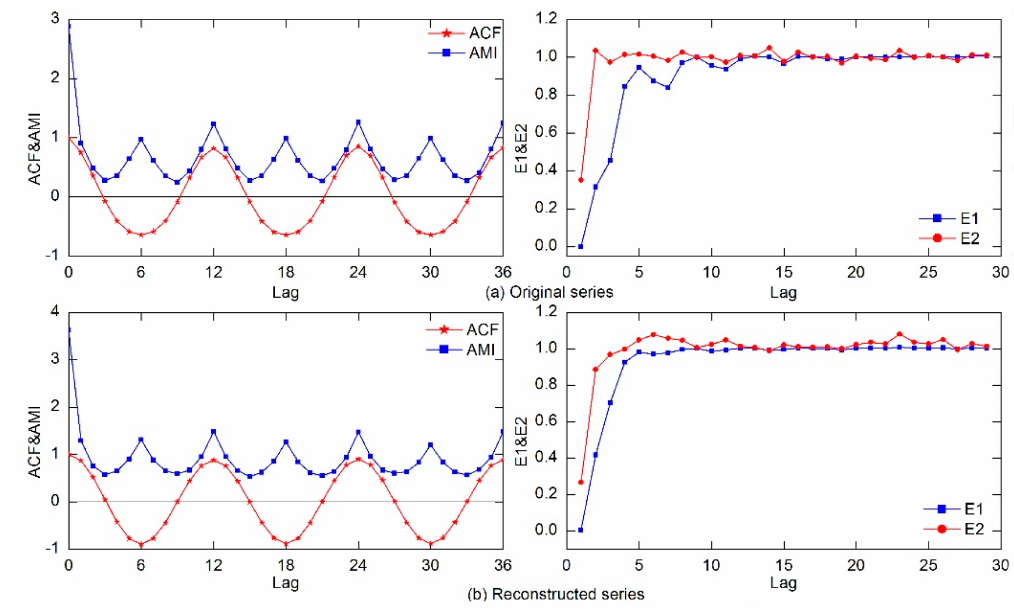
Figure 5. The auto-correction function (ACF) & Average Mutual Information (AMI) values and Cao method results plot for the original and reconstructed streamflow